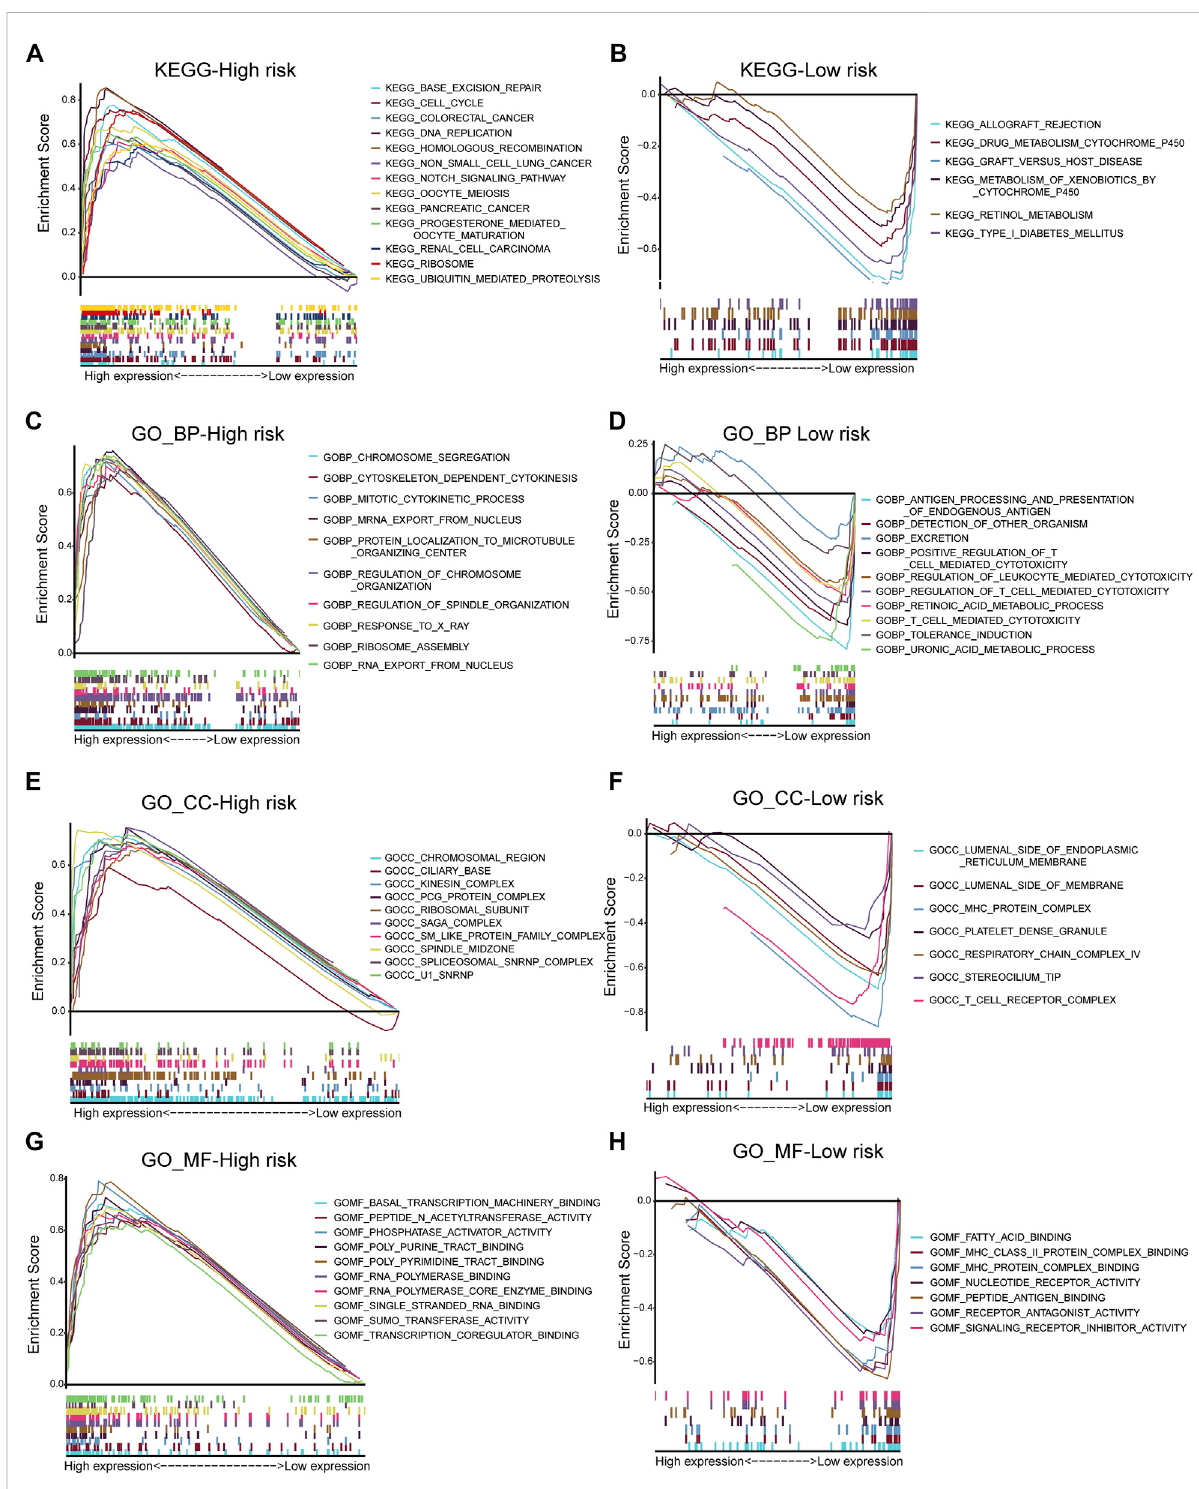
FIGURE 7 KEGG analysis of low- and high-risk groups (A,B) . GSEA analysis of BP, CC and MF in low- and high-risk groups (C – H)